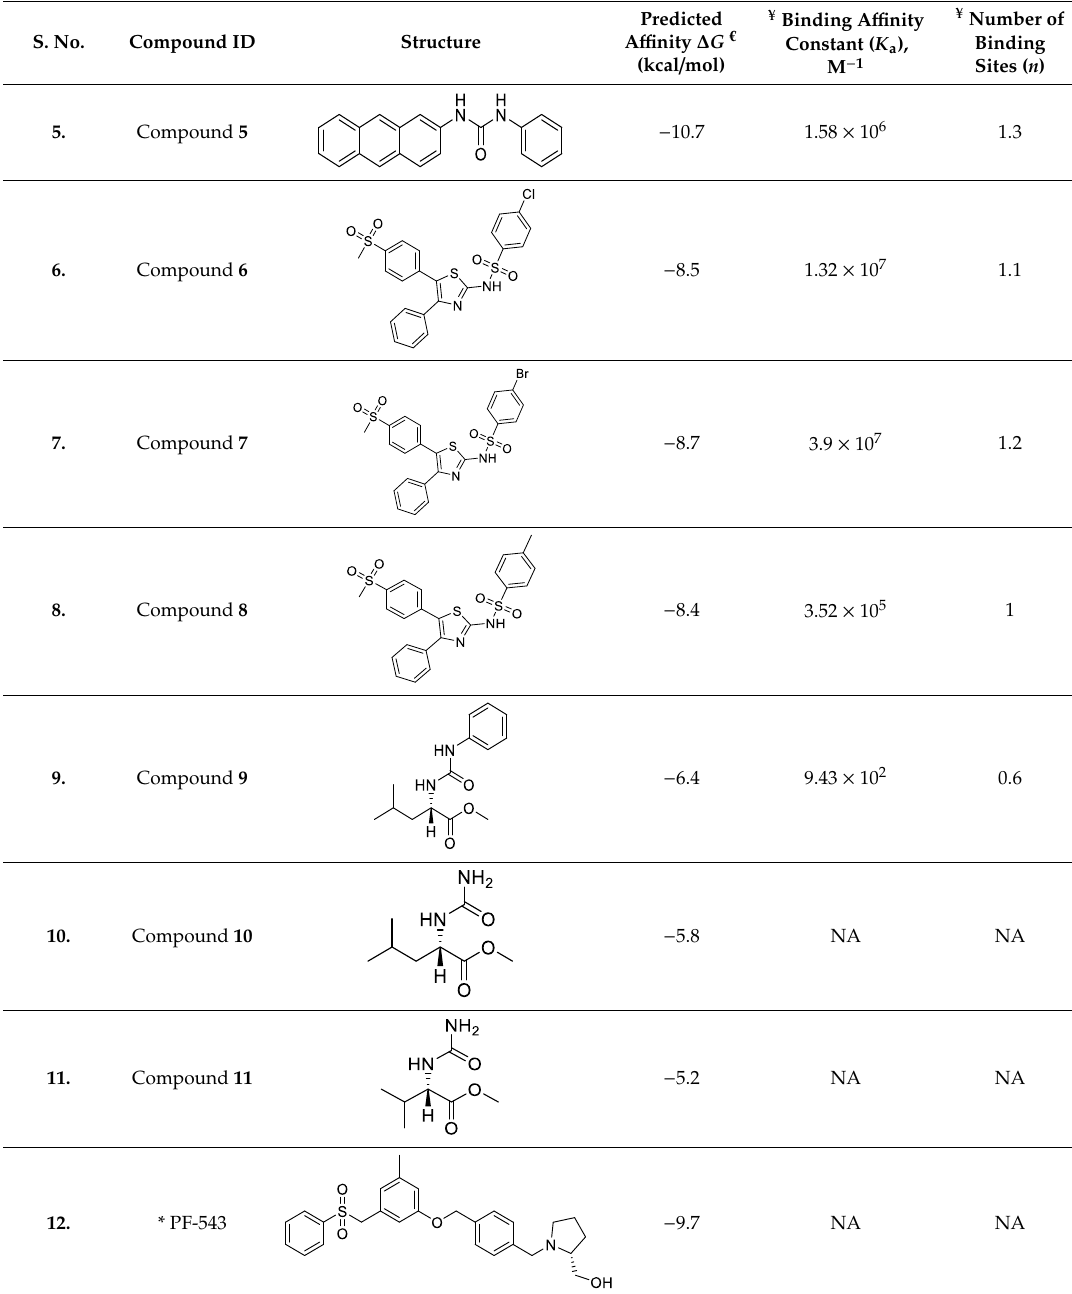
(F) Figure 5. Binding studies of Compounds 6 , 7 , and 8 with SphK1. Fluorescence emission spectra representing SphK1 with the addition of ( A ) Compound 6 (0–0.92 μM), ( B ) Compound 7 (0–0.5 μM), and ( C ) Compound 8 (0–26.1 μM). SphK1 was excited at 280 nm, and emission spectra were recorded in the range of 300–400 nm. Modified Stern–Volmer plot showing quenching of SphK1 fluorescence with increasing concentrations of ( D ) Compound 6 , ( E ) Compound 7 , and ( F ) Compound 8 . Table 1. Binding parameters of all the synthesized compounds with SphK1 obtained from molecular docking and fluorescence binding studies. S. No. Compound ID Structure Predicted Affinity Δ G € (kcal/mol ) ¥ Binding Affinity Constant ( K a ), M −1 ¥ Number of Binding Sites ( n